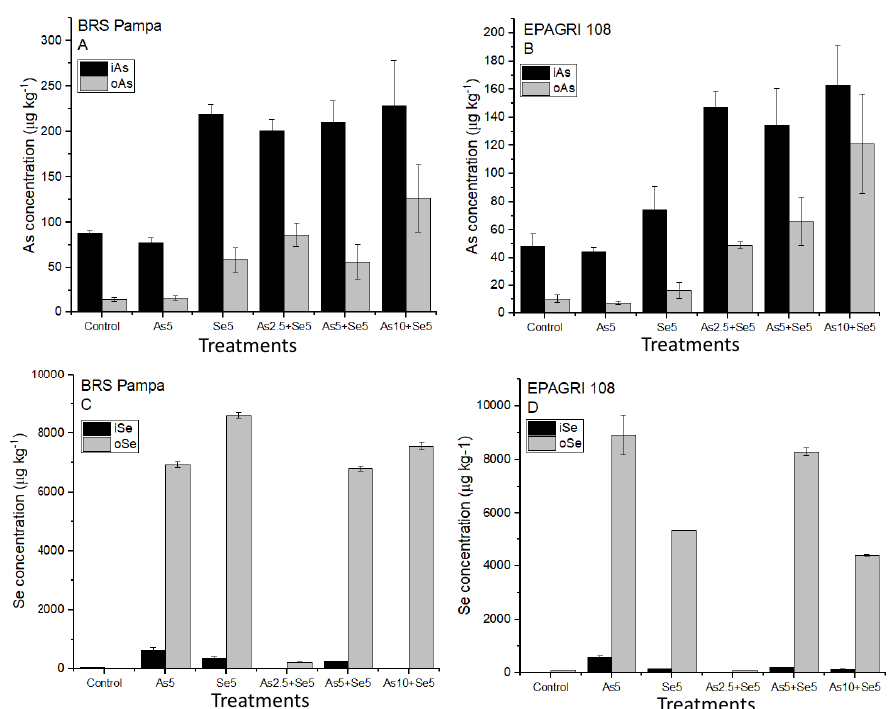
Figure 1. Organic and inorganic As and Se accumulated in the grains of the cultivars tested. Bars not shown are under the limit of detection. Treatments: Control, As5, Se5, As2.5 + Se5, As5 + Se5, and As10 + Se5. ( A ) organic and inorganic As in BRS Pampa cultivar; ( B ) organic and inorganic As in EPAGRI 108 cultivar; ( C ) organic and inorganic Se in BRS Pampa cultivar; ( D ) organic and inorganic Se in EPAGRI 108 cultivar.